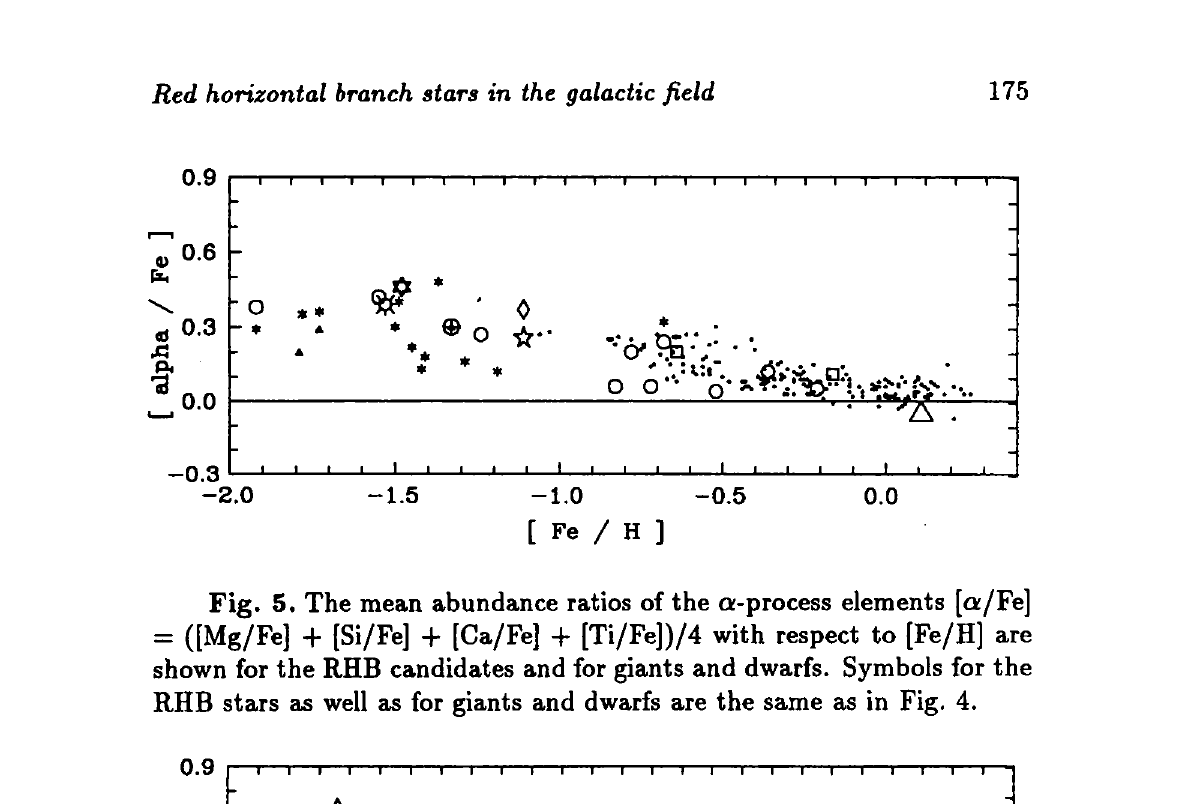
Fig. 5. The mean abundance ratios of the a- pro cess elements [a/ Fe] = ([Mg/Fe] + [Si/Fe] + [Ca/Fe] + [Ti/Fe])/4 with respect to [Fe/H] are shown for the RHB candidates and for giants and dwarfs. Symbols for the RHB stars as well as for giants and dwarfs are the same as in Fig. 4.